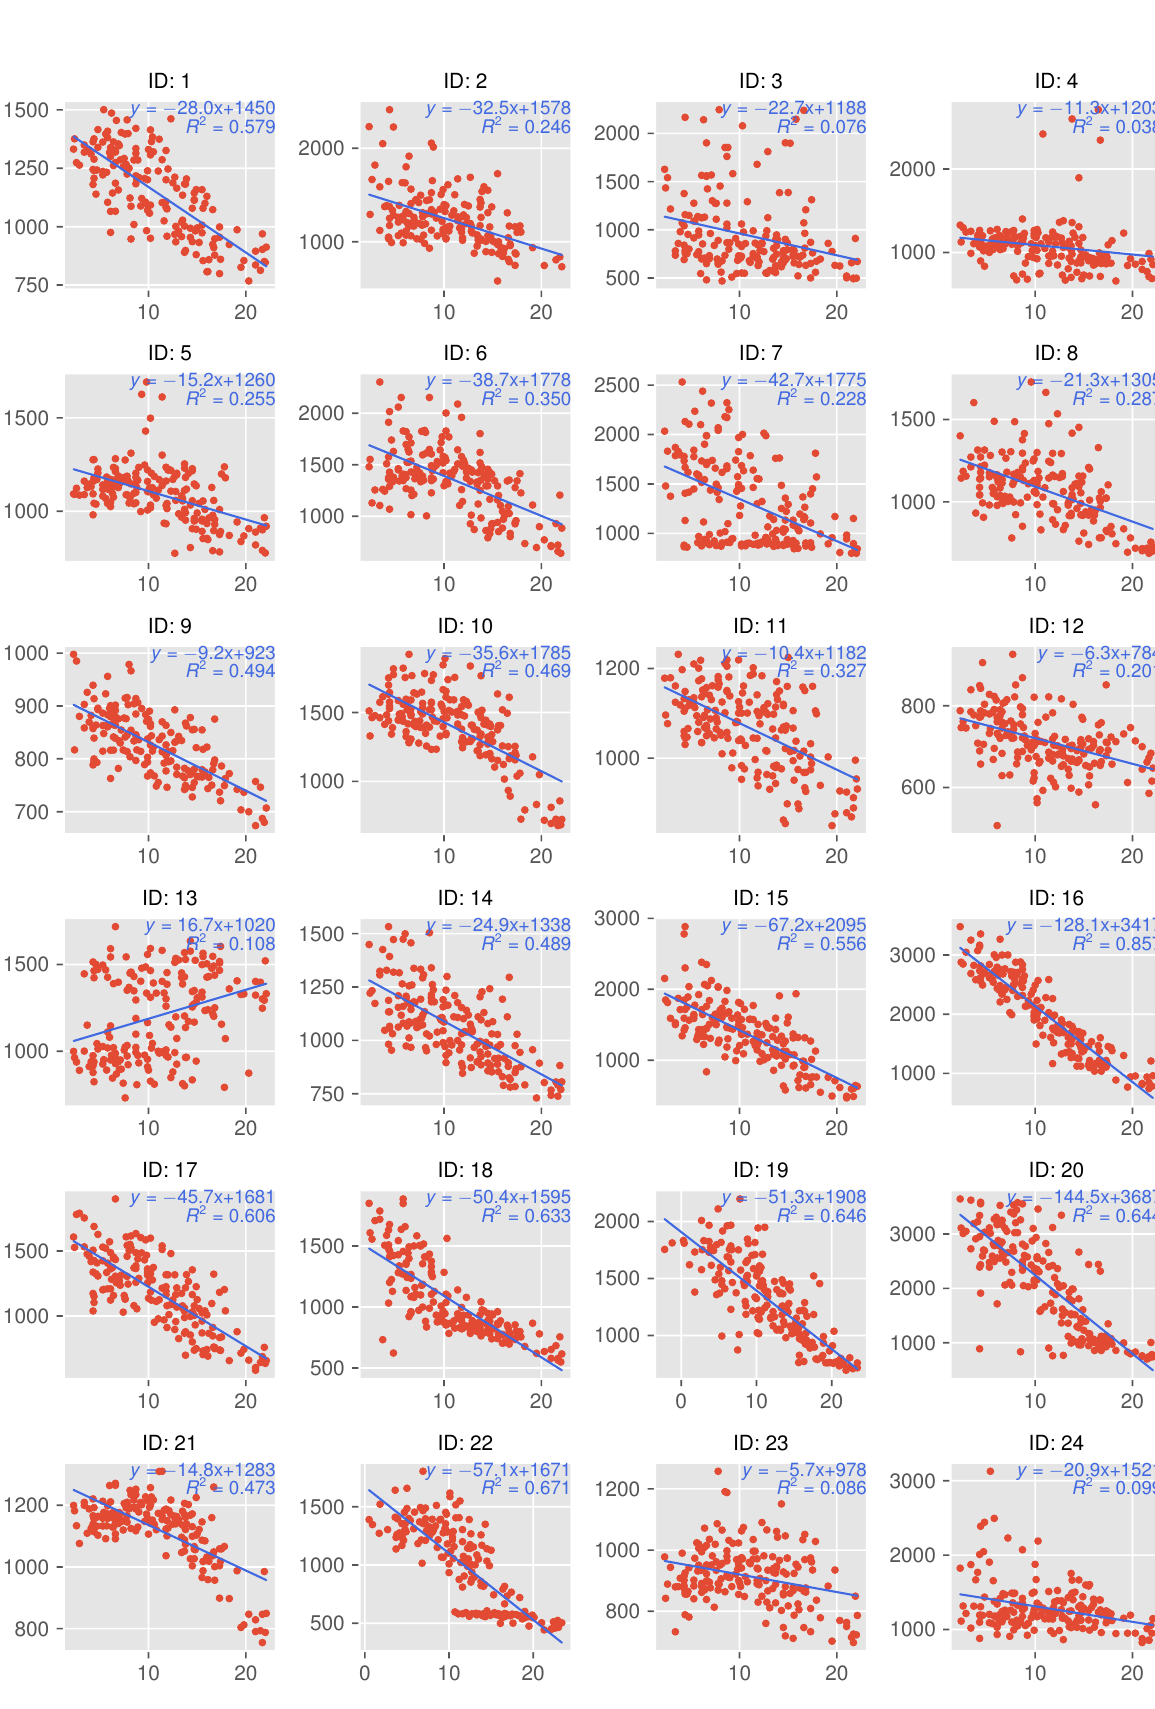
Figure 6. Relationship between daily averages of indoor CO 2 concentration and outdoor